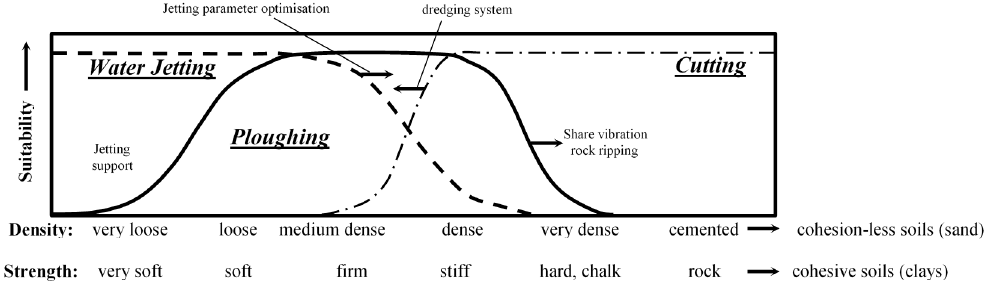
Figure 6. Indicative burial tool suitability in different ground conditions. Table 2. Comparison of Burial Techniques [25] (for the assessment see (1) ).